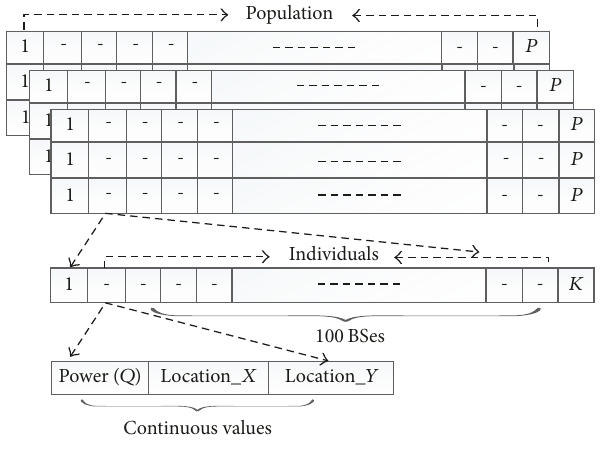
Figure 1: The structure of